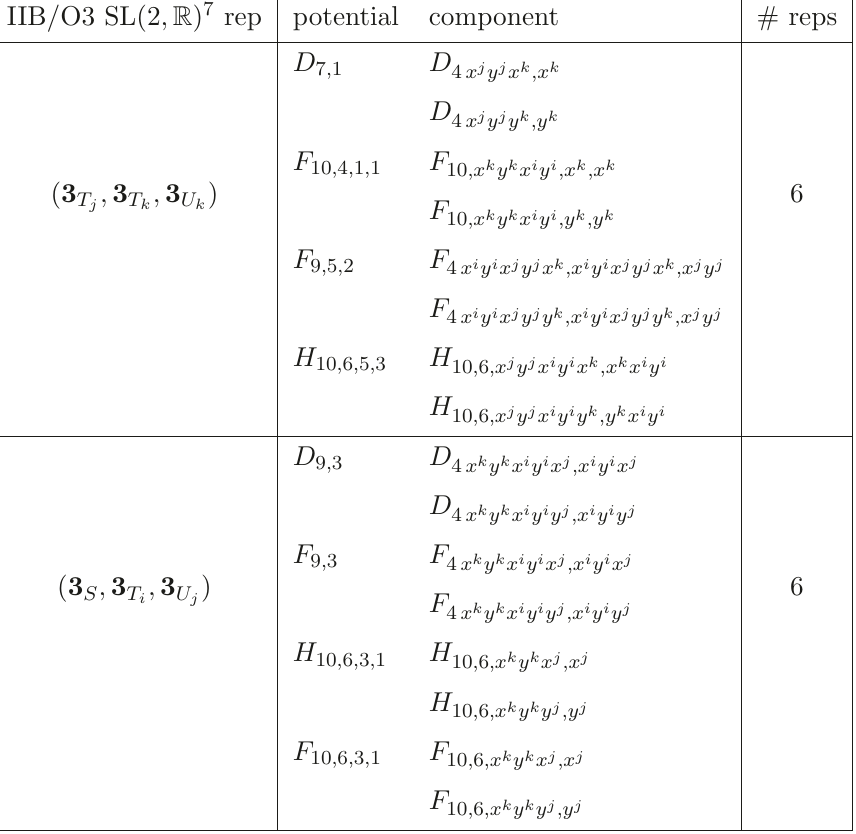
Table 10 . The SL(2 , R ) 7 representations of the forbidden IIB/O3 potentials which couple to space-filling branes with α even. The branes are 96 in number and are embedded in 12 different